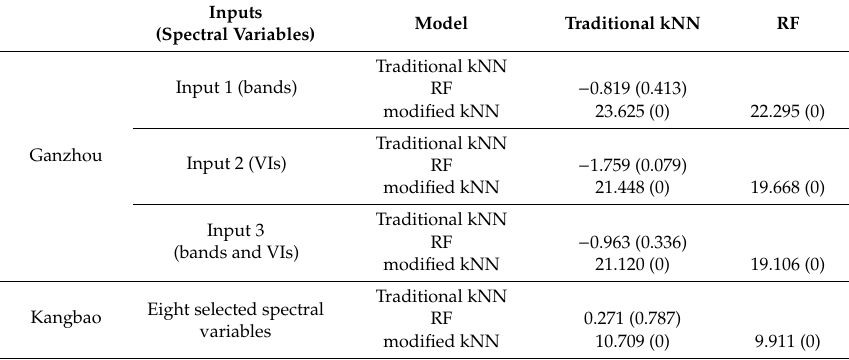
Table A3. The test values ( p -values) of significant di ff erences among the models for each of the input sets of spectral variables based on the absolute residuals between the estimated and observed LAI values using the student_T distribution in Ganzhou and